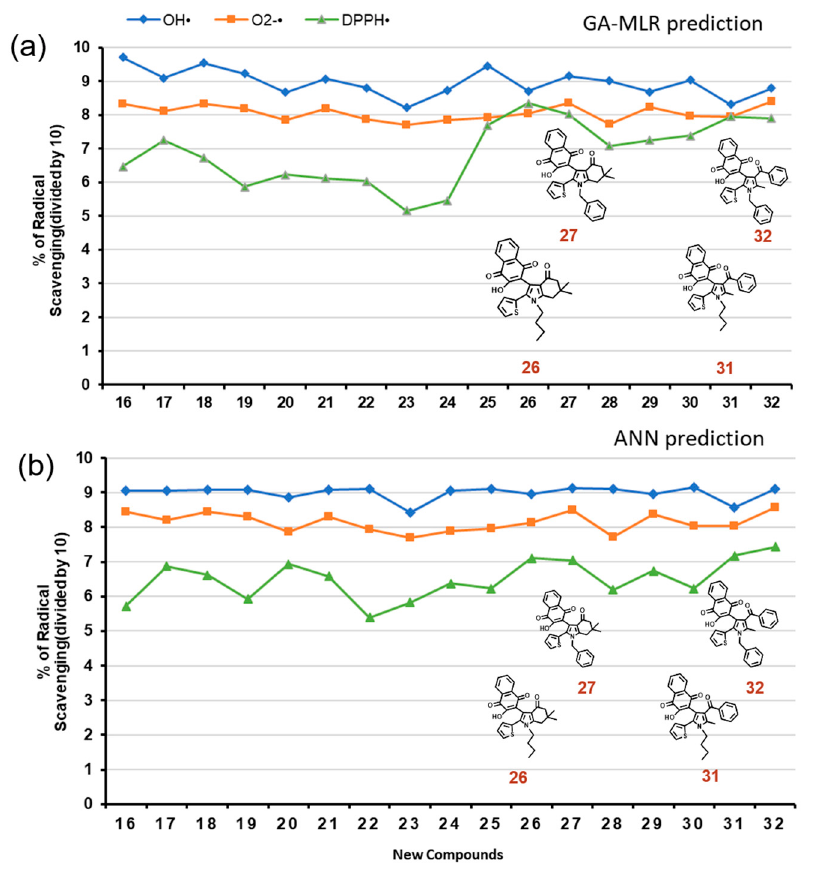
Figure 4. Predicted antioxidant activities toward • OH, O 2 •− , and DPPH • of the newly designed compounds obtained via the ( a ) GA-MLR and ( b ) ANN methods.